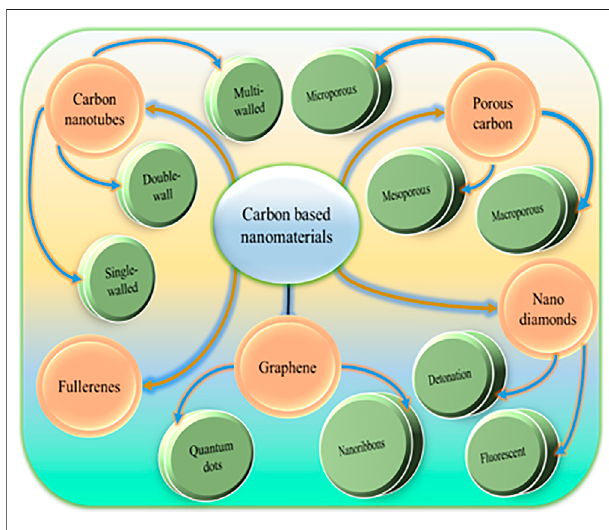
FIGURE 1 | Classi fi cation of CBNs according to their shape and geometrical